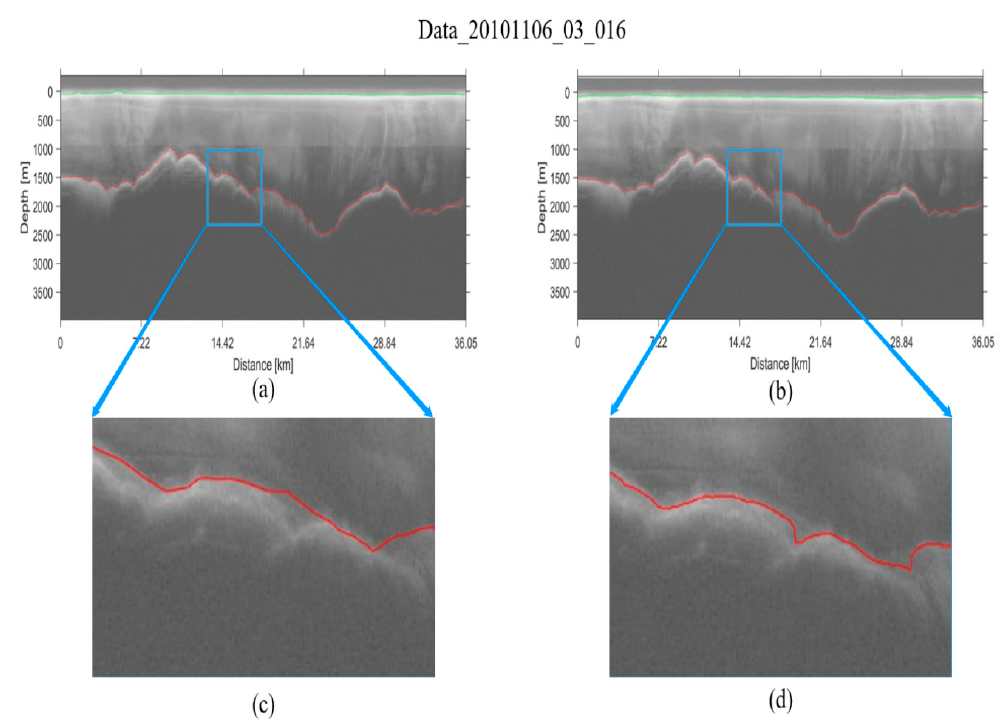
Figure 9. ( a ) Manually picked interfaces. ( b ) The boundary map generated with the presented method. ( c , d ) Magnified section of (a,b). Each color represents a di ff erent boundary: ice surface (green); ice ( c , d ) Magnified section of (a,b). Each color represents a different boundary: ice surface (green); ice bottom bottom (red).